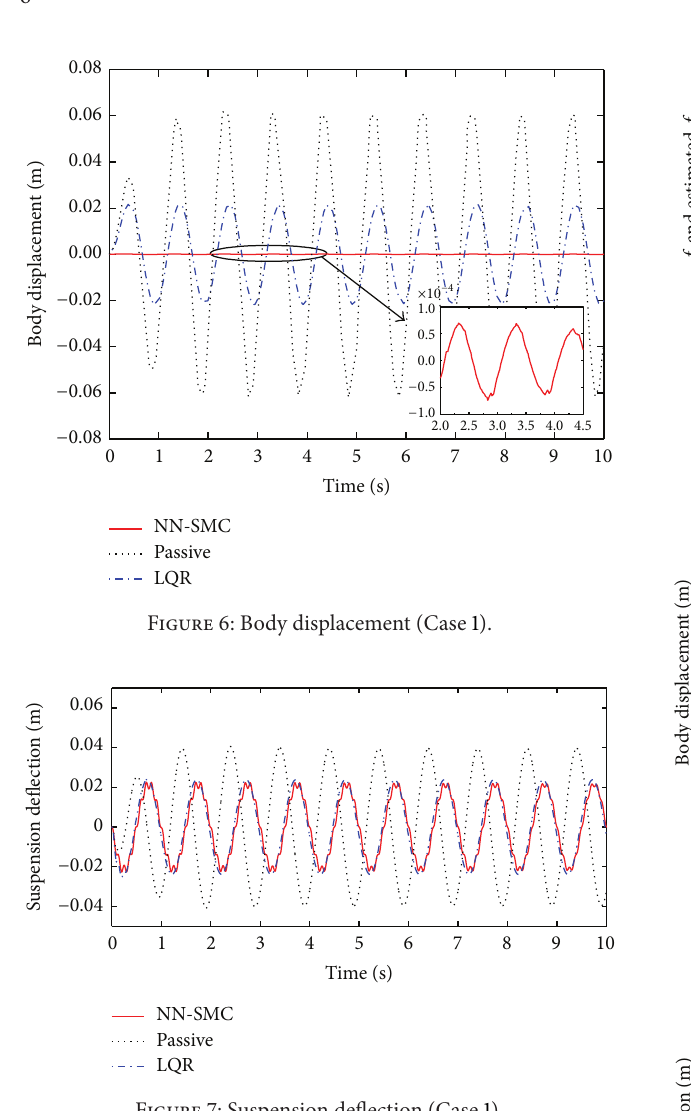
Figure 7: Suspension deflection (Case 1).